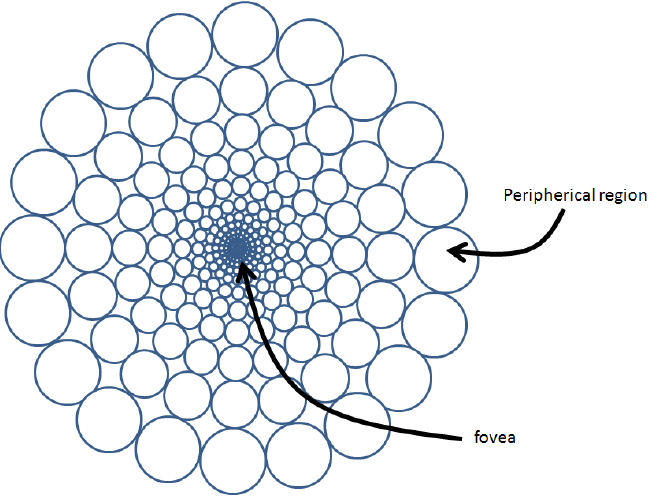
Figure 1. Approximated distribution of cones on the human retina, providing brain pixels of an adapted size distributed following a polar pattern (adapted from the original from C.Ware, 2008, p. 5